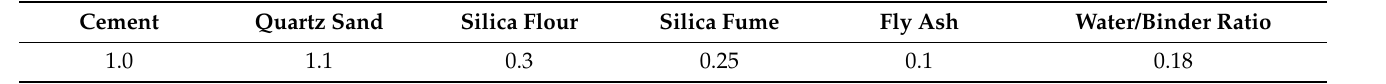
Table 3. Mix proportion design of UHPC (mass/cement mass ratio) [43].